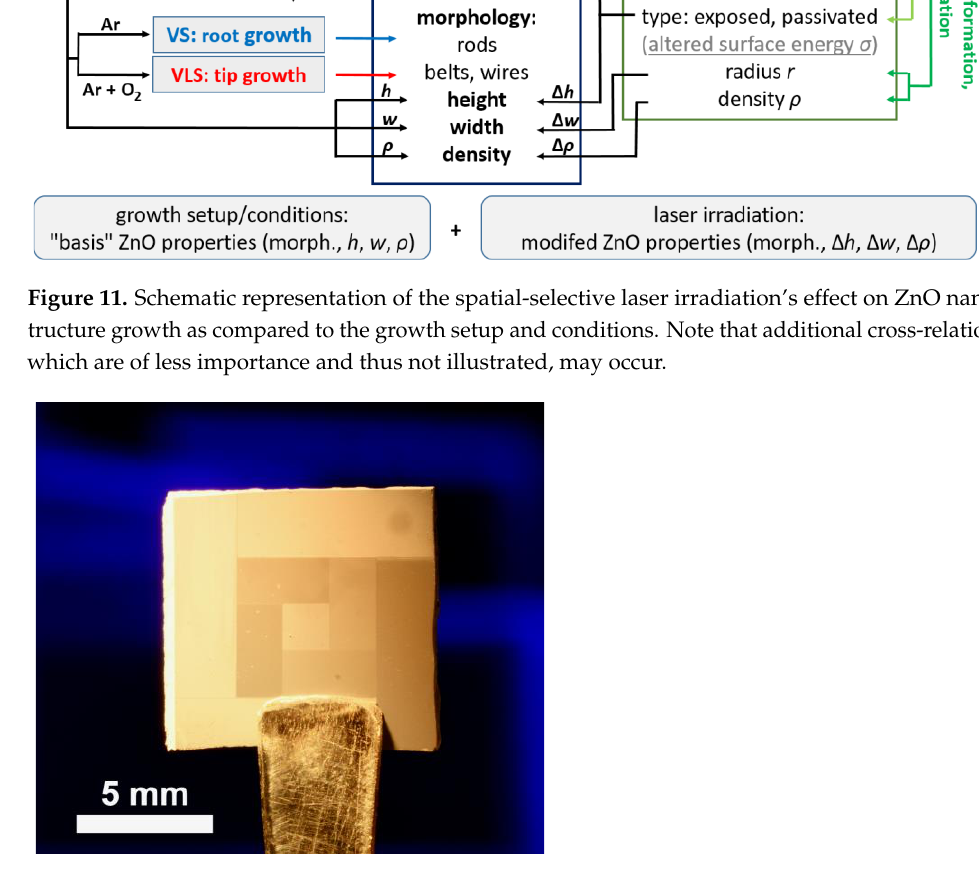
Figure 11. Schematic representation of the spatial-selective laser irradiation’s effect on ZnO nanostructure growth as compared to the growth setup and conditions. Note that additional cross- relations, which are of less importance and thus not illustrated, may occur.